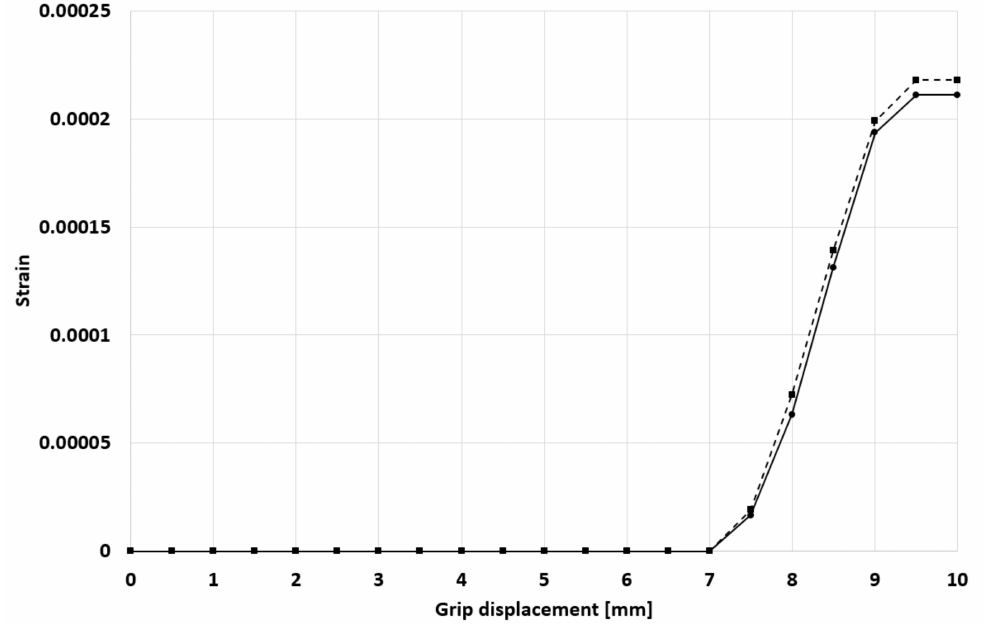
Figure 15. The evolution of the plastic strain components for Specimen_0 versus grip displacement at the central point of the samples: e11 – dashed line, e22 – solid